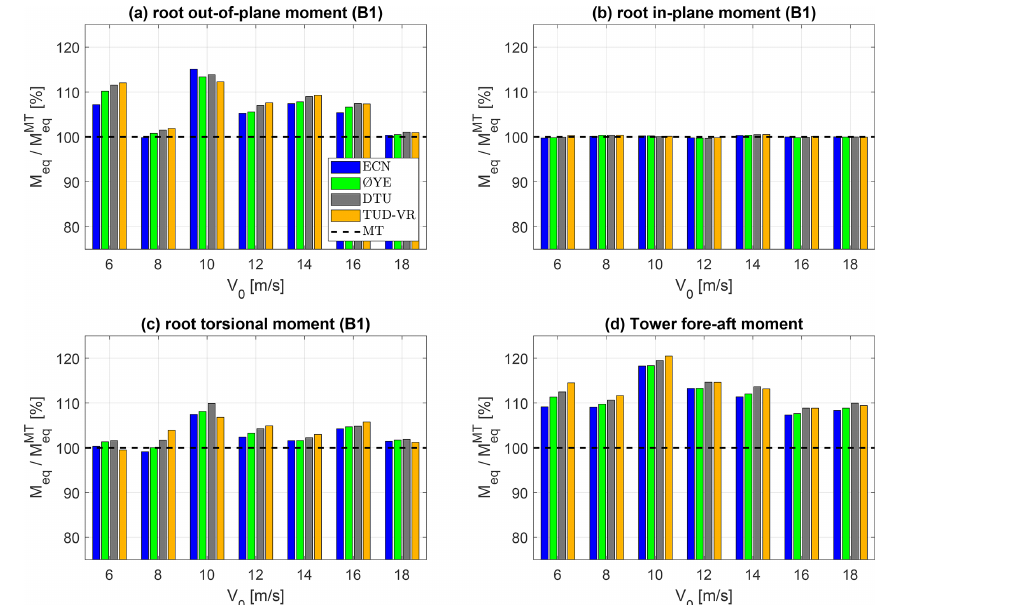
Figure 10. Comparison of 1Hz equivalent moments obtained with the different dynamic inflow models for different wind speeds in DLC 1.2. The equivalent out-of-plane (a) , in-plane (b) , and torsional (c) moments at the root of blade no. 1 are reported along with the fore–aft moment at the tower base (d) . All equivalent moments are normalized by the value obtained without using dynamic inflow models